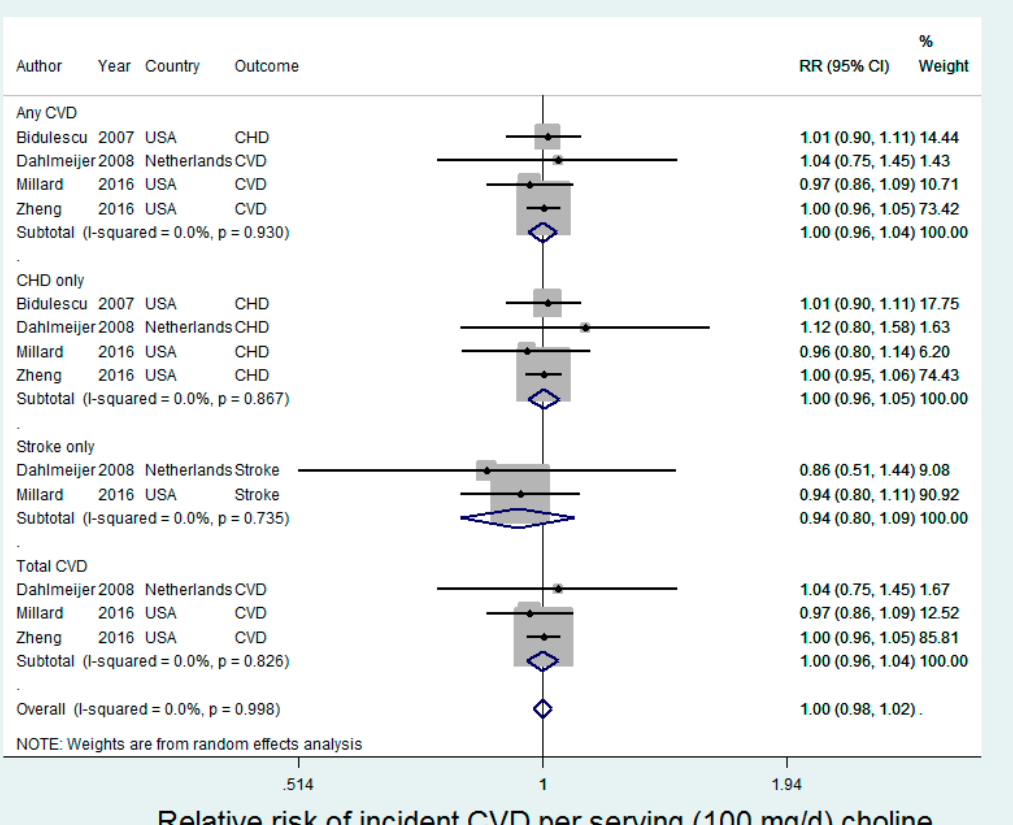
Figure 1. Choline intake and CVD incidence.